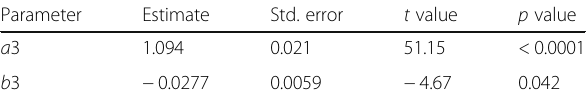
Table 7 Parameter estimates for sub-model 3. The model pre- dicts the sheath to breast height wood density ratio as a func- tion of breast height ring number from pith, and was fitted to Douglas-fir data from eight sites in New Zealand. The model R 2 = 0.49